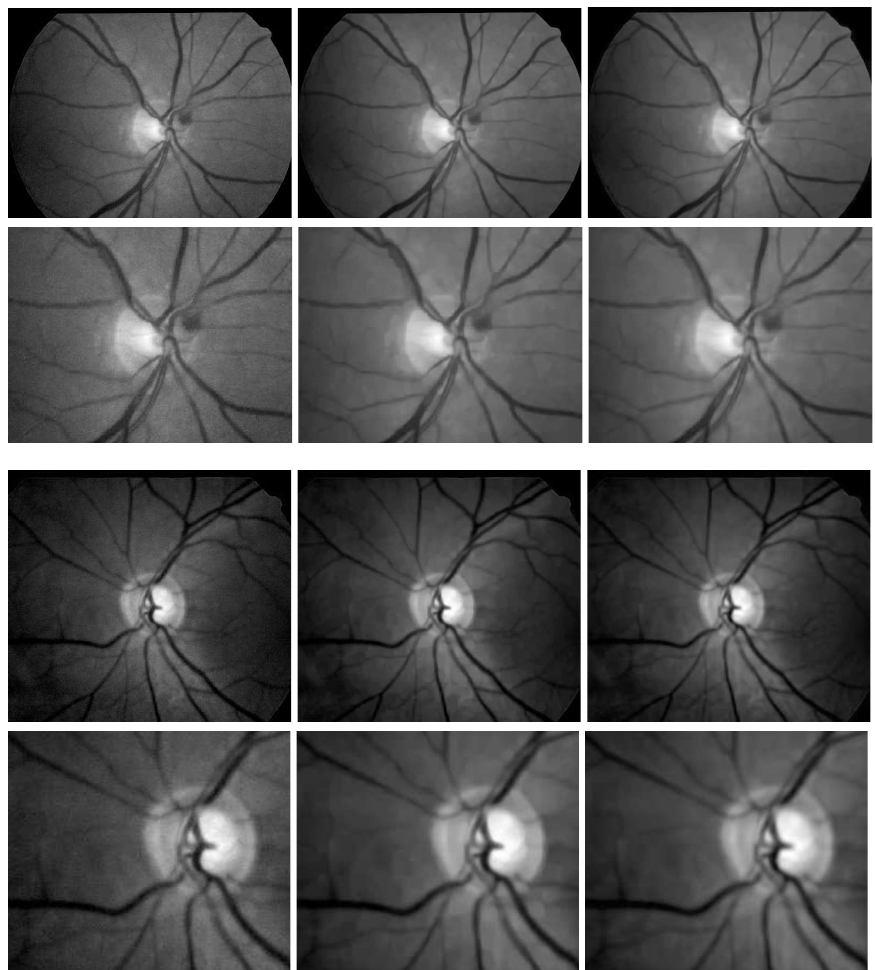
Figure 4. Comparison of visual denoising results of the proposed ES-BM3D (shown in the second column) against the S-BM3D method (shown in the third column) on two noisy (fundus) images (shown in first column) from the DRIONS dataset [74]. The figure is arranged such that the first and third rows show the noisy and denoised images while the second and third row shows the zoomed in views of specific regions from the images in their top